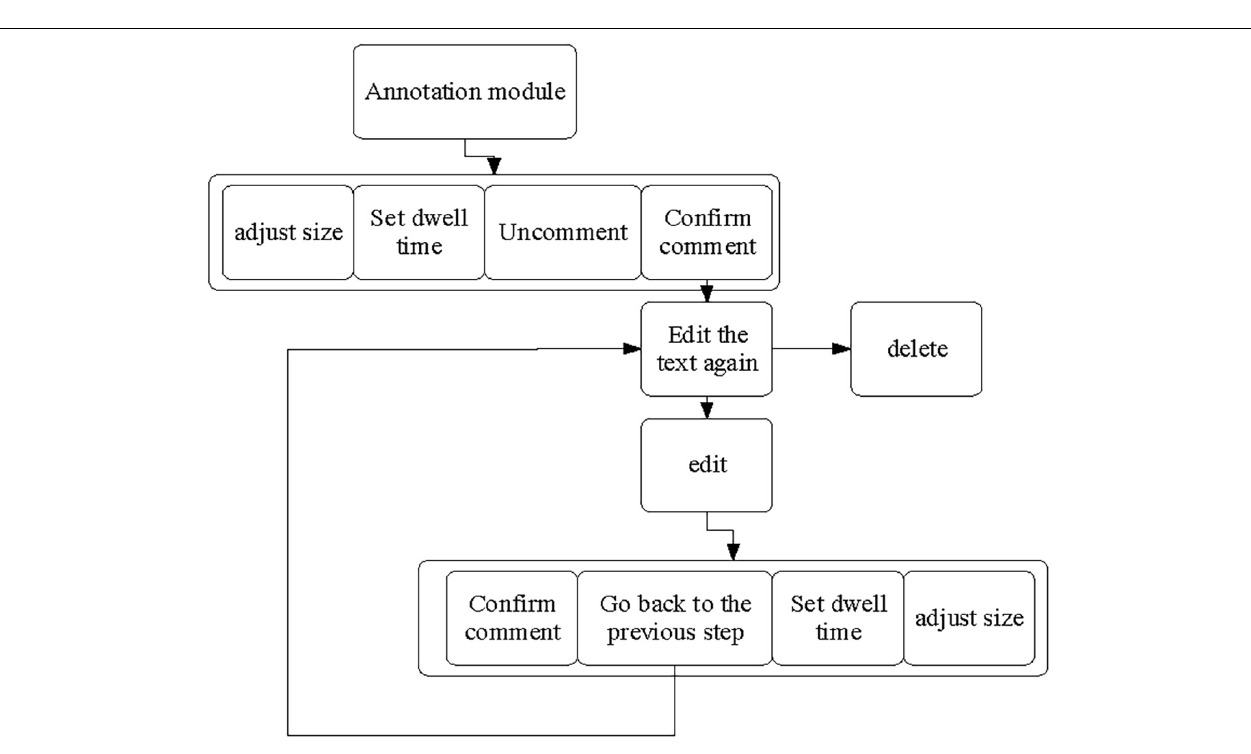
FIGURE 3 | Main operations and interactive relationship chains (A represents comments visible only to the author and the publisher; B represents comments open to all users).